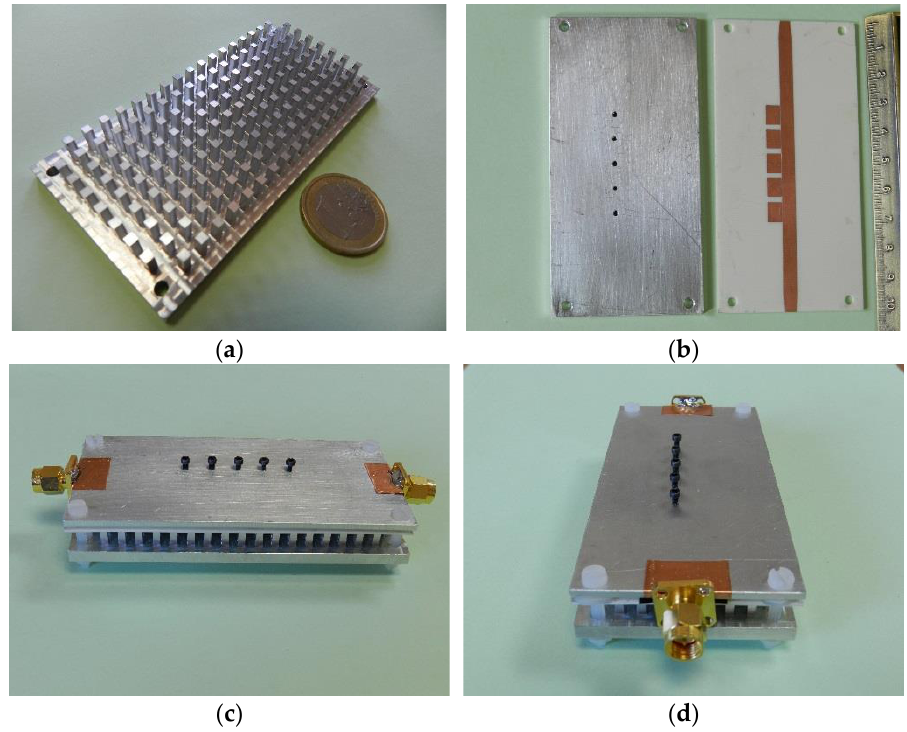
Figure 16. Demonstrator manufactured with 5-resonators: ( a ) Bed of nails ( b ) Printed circuit board and top plate in aluminum with the thread for the screws ( c ) General view of the gap waveguide assembly with the short-circuit screws ( d ) Detail of the SMA connectors and soldering.